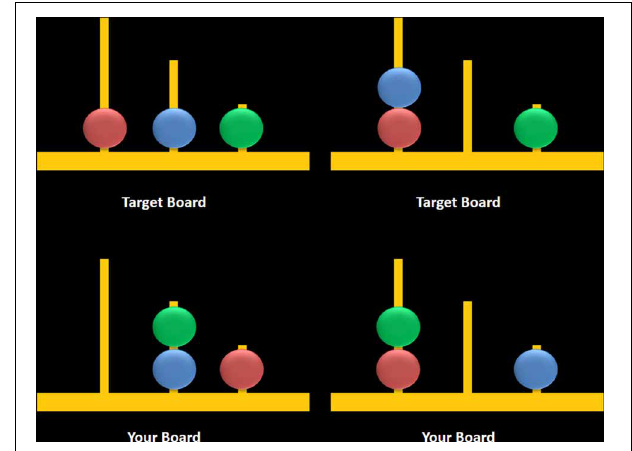
FIGURE 8 | Sample three-move problems from the Scarborough adaptation of the Tower of London task that are low (left) vs. high (right) in search depth. These sample problems require a minimum of three moves to solve the problem and they either require an intermediate move (left) or do not require an intermediate move to achieve the target configuration